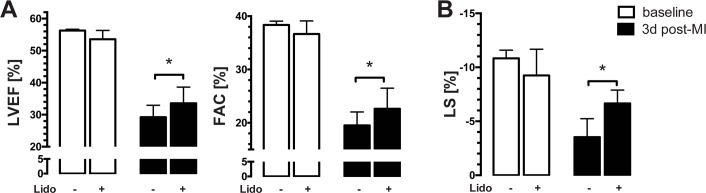
Lidocaine treatment rescues global systolic function during ischemia.Absolute values of conventional echocardiographic parameters EF and FAC (A) and speckle-tracking derived LS (B) before (white bars) and 72h following LAD ligation (black bars) with lidocaine or vehicle are given. EF, FAC and LS are partially rescued with lidocaine (*p = 0.0184 for EF; *p = 0.0343 for FAC; *p = 0.0198 for LS). EF ejection fraction, FAC fractional area change, LS longitudinal strain.